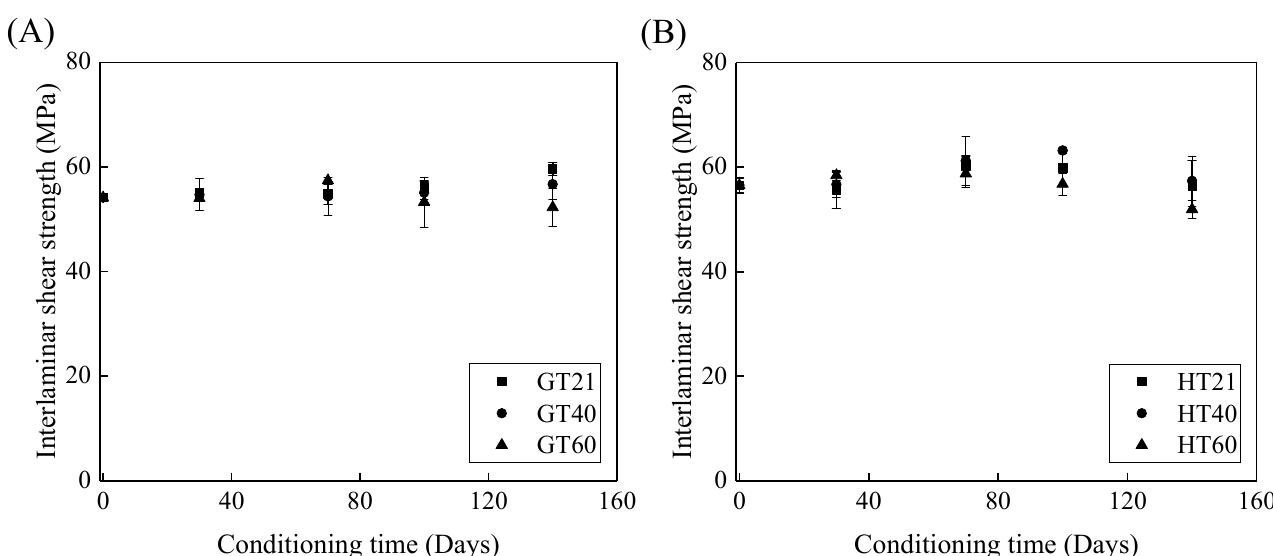
Figure 9. The effect of the immersion period on the interlaminar shear strength of ( A ) the GFRP bars and ( B ) the HFRP bars.